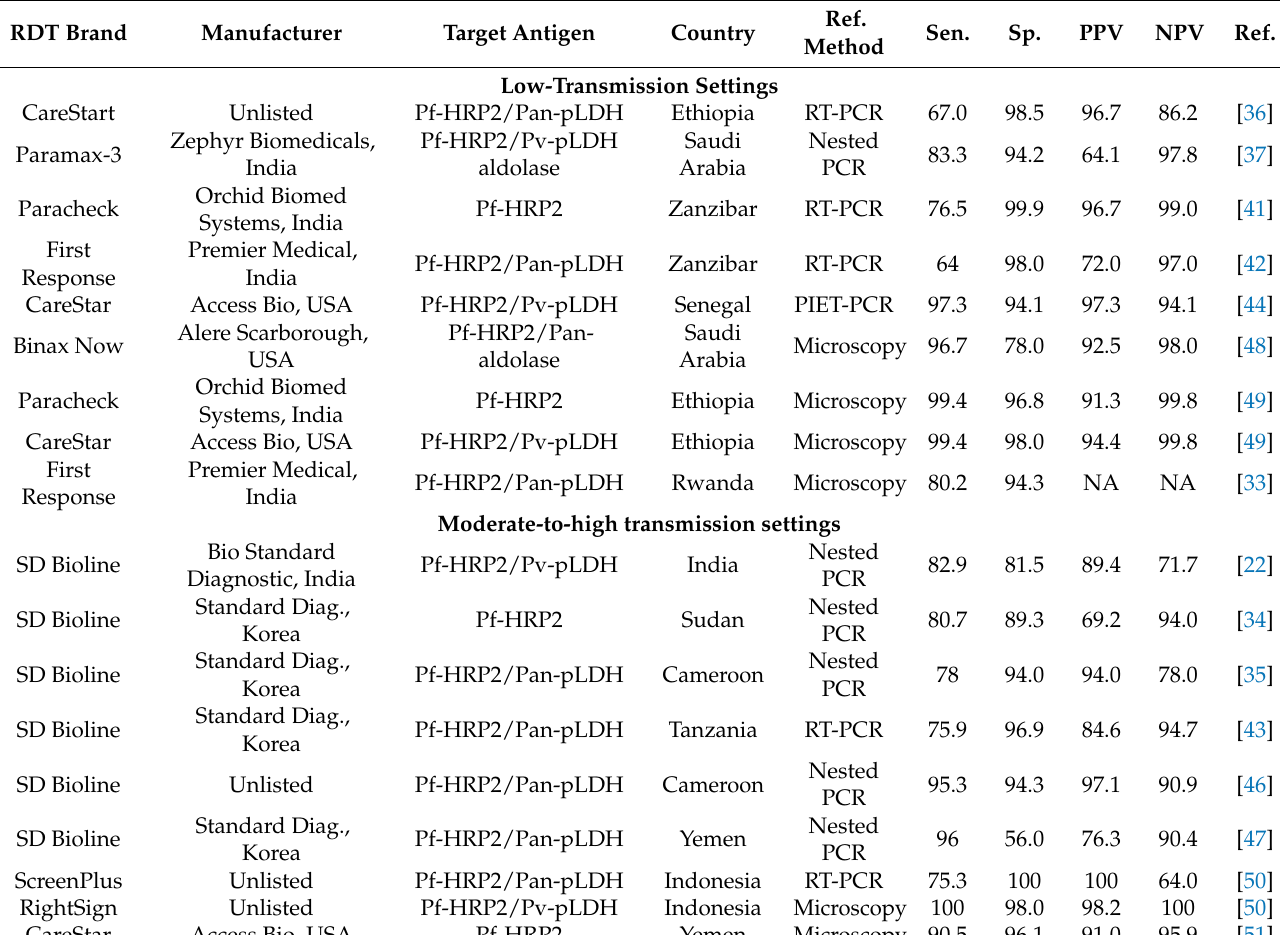
Table 5. Performance of different RDTs for detection of P. falciparum infection at different transmis- sion